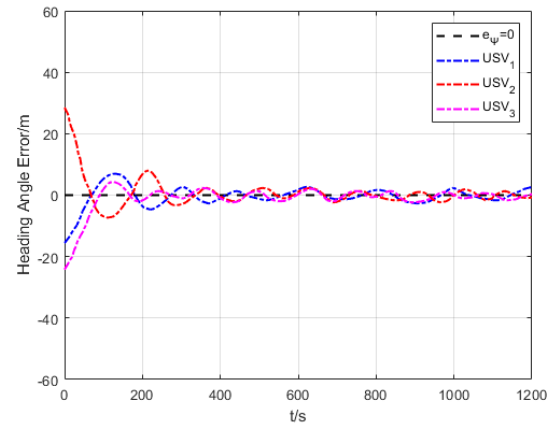
Figure 34. Variation of USV longitudinal error.